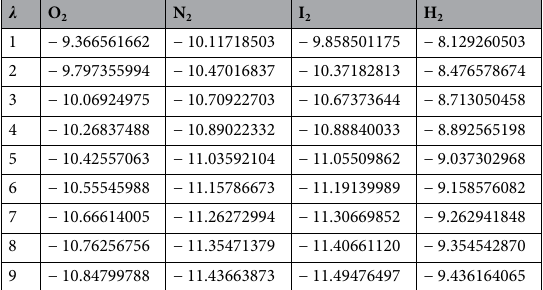
Table 8. Shannon entropy in position space of some diatomic molecules with n = ℓ = (cid:31) =